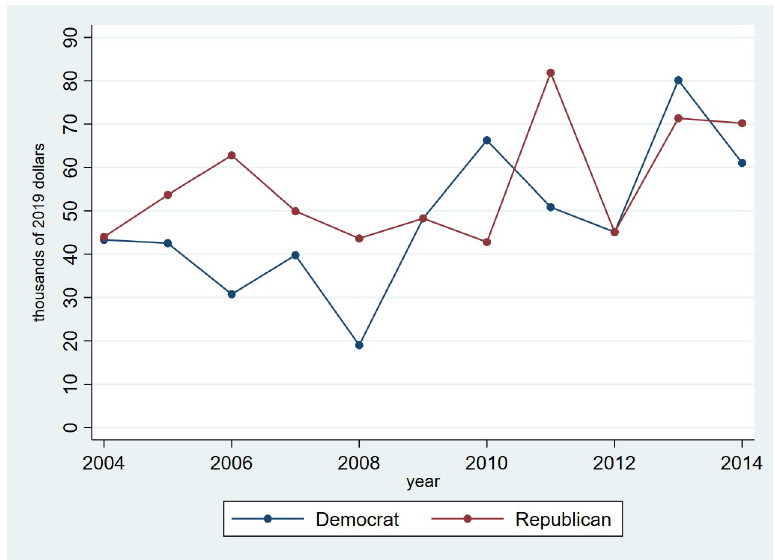
Fig 2. Median total value of health care-related assets per member per year, by party among those holding at least one health asset in a given year.